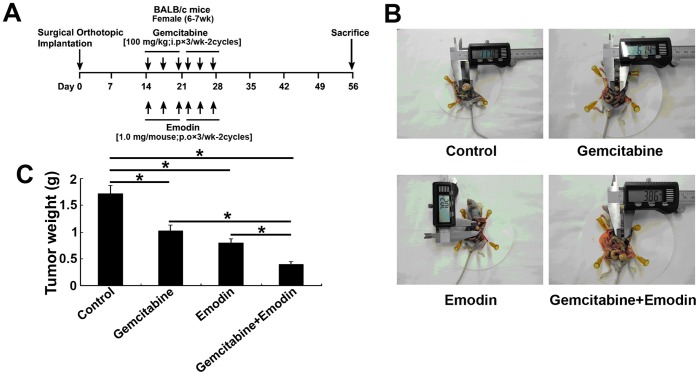
(A) Schematic illustration of experimental protocol. (B) Photographs of orthotopically implanted pancreatic tumors on day 28 following treatment. The combined treatment of emodin and gemcitabine significantly inhibited tumor growth. (C) The tumor weights of individual groups of mice on the last day of the experiment (Day 37). *, P<0.05.